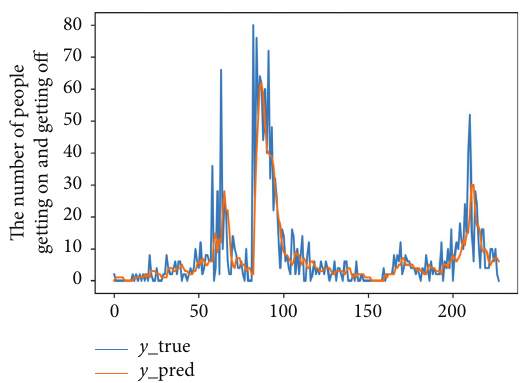
Figure 23: Regression integration prediction results when the time step is 2h.